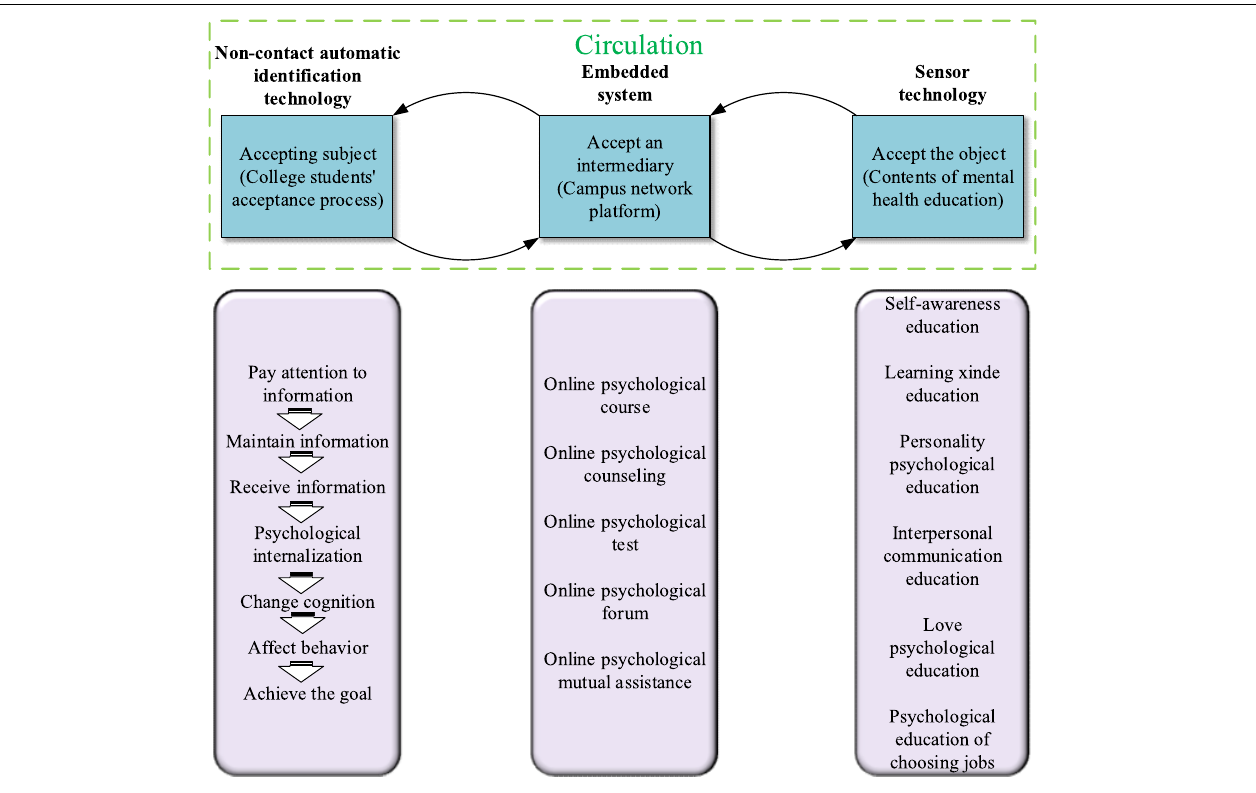
FIGURE 6 | Construction structure of college students’ mental health big data network.